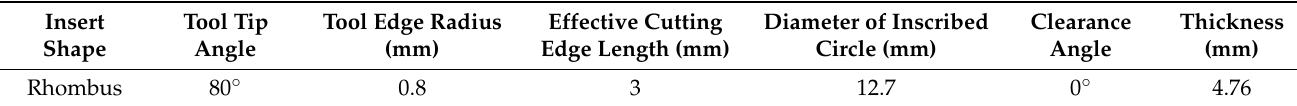
Table 4. Geometric parameters of the PCBN